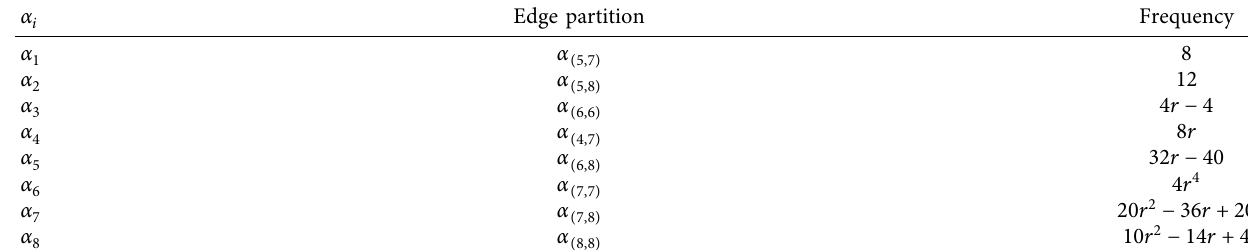
r � 3. n × n for n × n